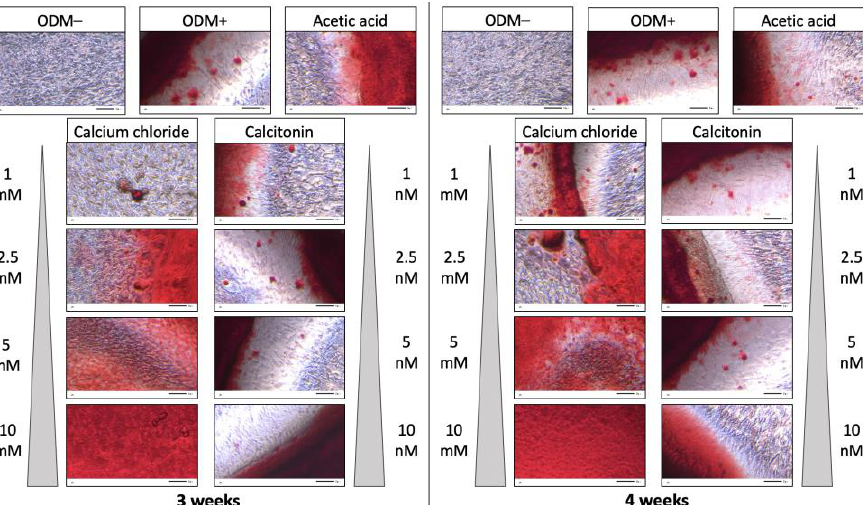
Figure 1. Alizarin red S staining of murine osteoblasts (MC3T3-E1) after incubation with calcium chloride or calcitonin. Cells were incubated with increasing calcium chloride (1, 2.5, 5, and 10 mM) or calcitonin (1, 2.5, 5, and 10 nM) concentrations for three ( left panel) or four weeks ( right panel) and subsequently stained with alizarin red S. Each condition was assessed in triplicate in three independent assays (n = 9). ODM − served as negative control (n = 6), ODM+ (n = 12) as reference, and acetic acid (n = 6) was used as an additional control as calcitonin was dissolved in acetic acid. Representative pictures of transmitted light microscopy at 20× magnification are shown. Scale bar is 50 µm. ODM; osteoblast differentiation medium.